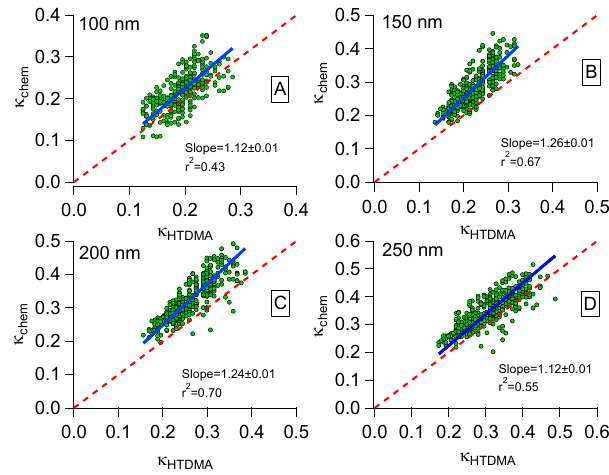
Fig. 5: Correlation between  chem and  HTDMA for particles with dry Dp=100, 150, 200, and 250 779 Fig. 5. Correlation between κ chem and κ HTDMA for particles with dry D p = 100, 150, 200, and 250nm, using size-segregated chemi- nm, using size-segregated chemical composition 780 cal composition